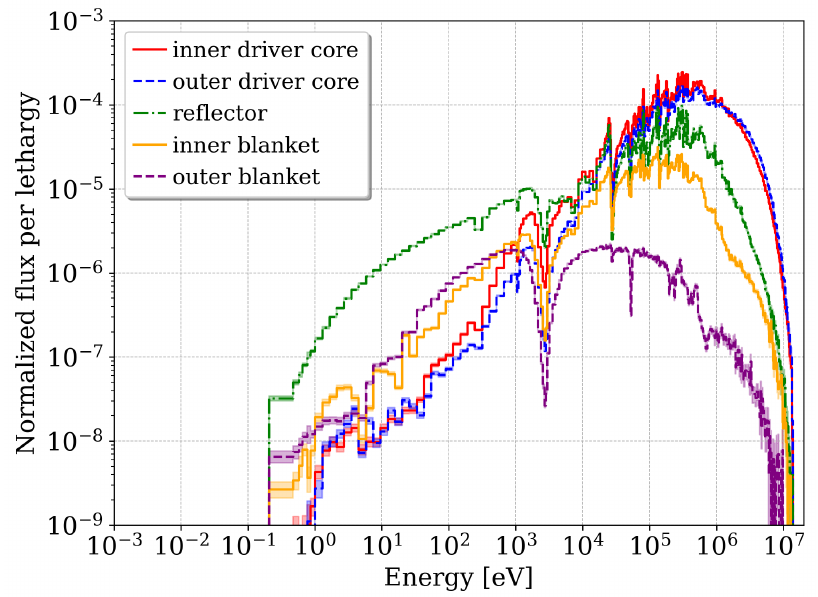
Figure 7. Normalized neutron flux in a 302-group representation at the core axial mid line, at different radial positions determined with